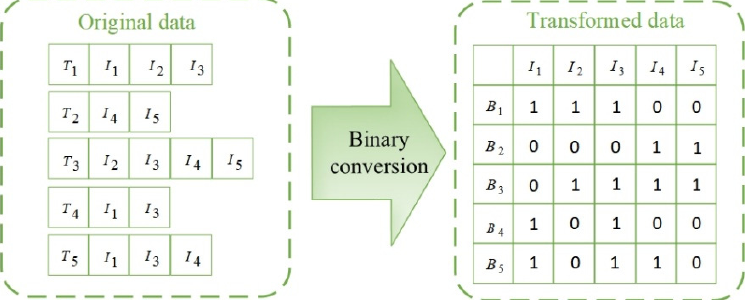
Figure 4. Binary conversion of data.